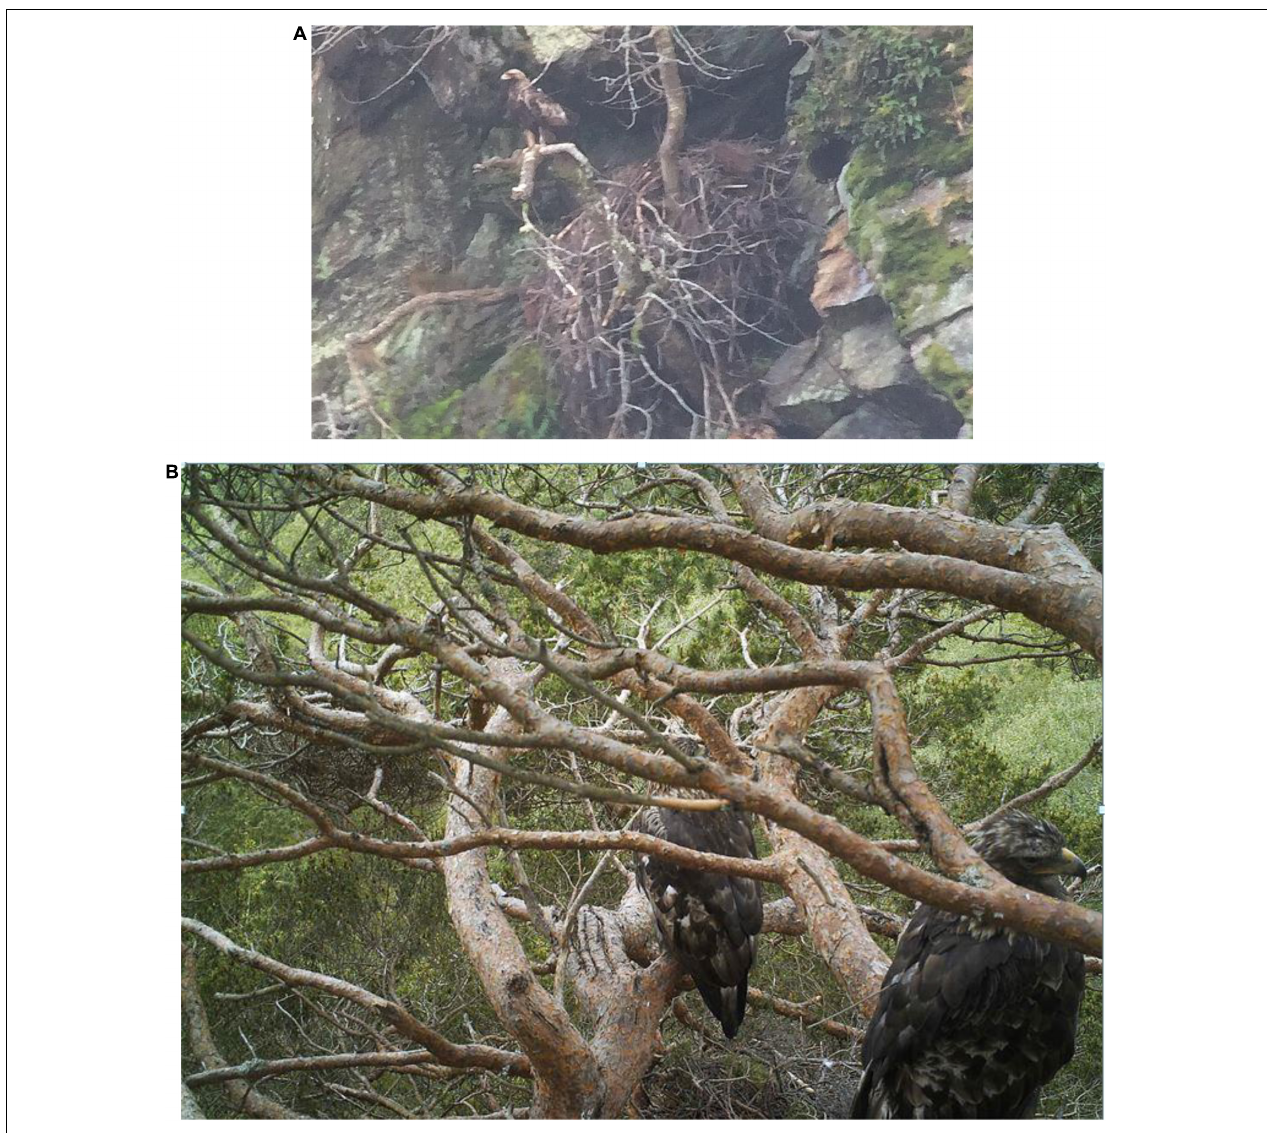
FIGURE 4 | Photographic examples contributing to field validation of territory occupation: (A) tagged female 148632 attending a nest in central Scotland in early April 2017 where she was building up the nest and paired with male 148640, another tagged bird ( Table 1 ) (Photo: Jonathan Clarke); (B) tagged sub-adult female 57115 (foreground) paired with an untagged sub-adult male in northeast Scotland in July 2017 (Photo: Ewan